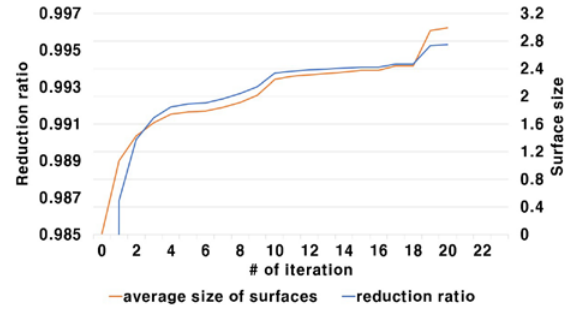
Figure 14. Changes of the number of surfaces and average Surface size in Soldification step